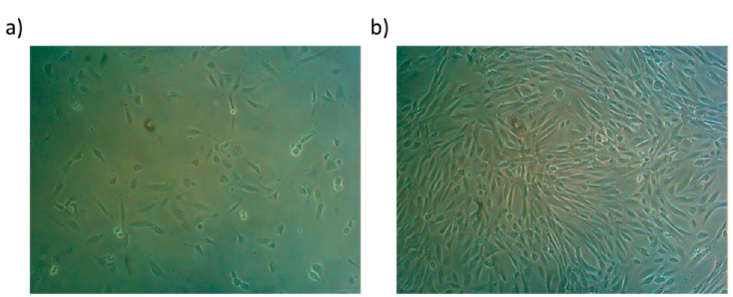
Figure 3. Cell morphology of early adherent urine-derived stem cells (USCs) 15 days ( a , P1) and 21 days ( b , P4) after isolation from urine specimens.